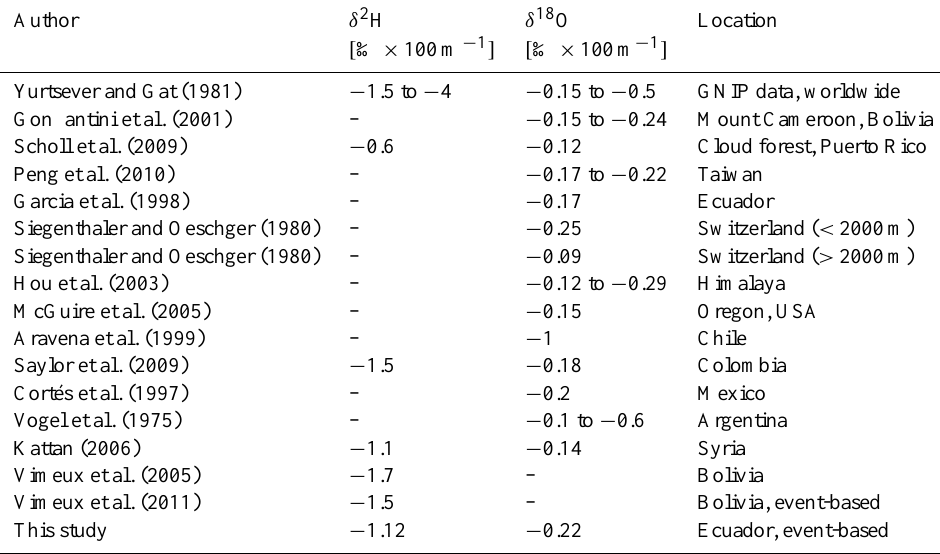
Table 3. Altitude effect of δ 2 H and δ 18 O in precipitation from various sites around the world. Author δ 2 H δ 18 O Location [ ‰ × 100m − 1 ] [ ‰ × 100m − 1 ] Yurtsever and Gat (1981) − 1.5 to − 4 − 0.15 to − 0.5 GNIP data, worldwide – − 0.15 to − 0.24 − 0.6 −